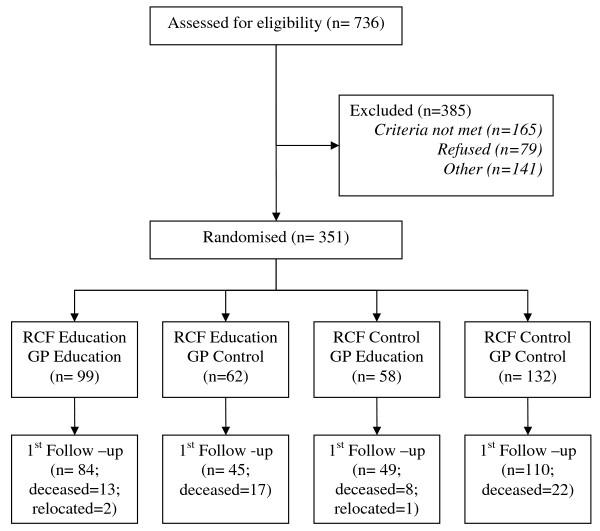
Study Flow Chart.